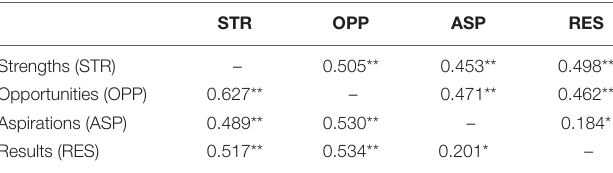
TABLE 4 | Standardized latent factor correlations from the ICM CFA (Model 1) and ESEM solutions (Model 4).